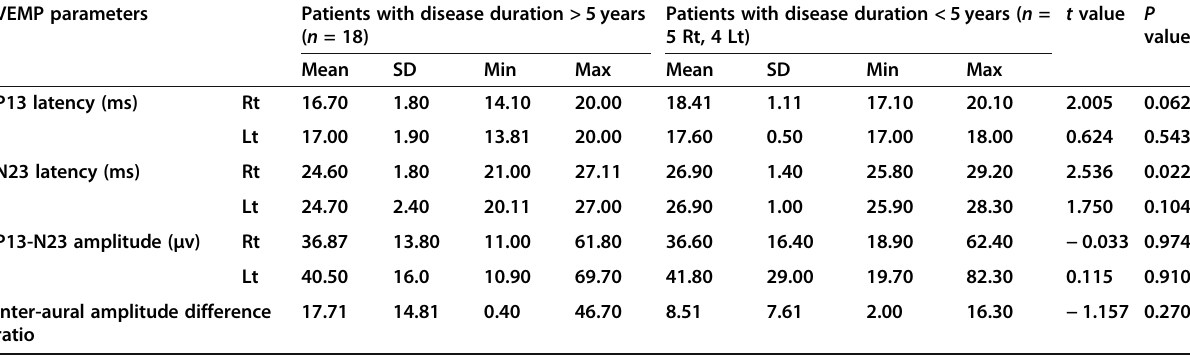
Table 6 Comparison between BD patients with disease duration > 5 years and < 5 years regarding VEMP results VEMP parameters Patients with disease duration > 5 years ( n =